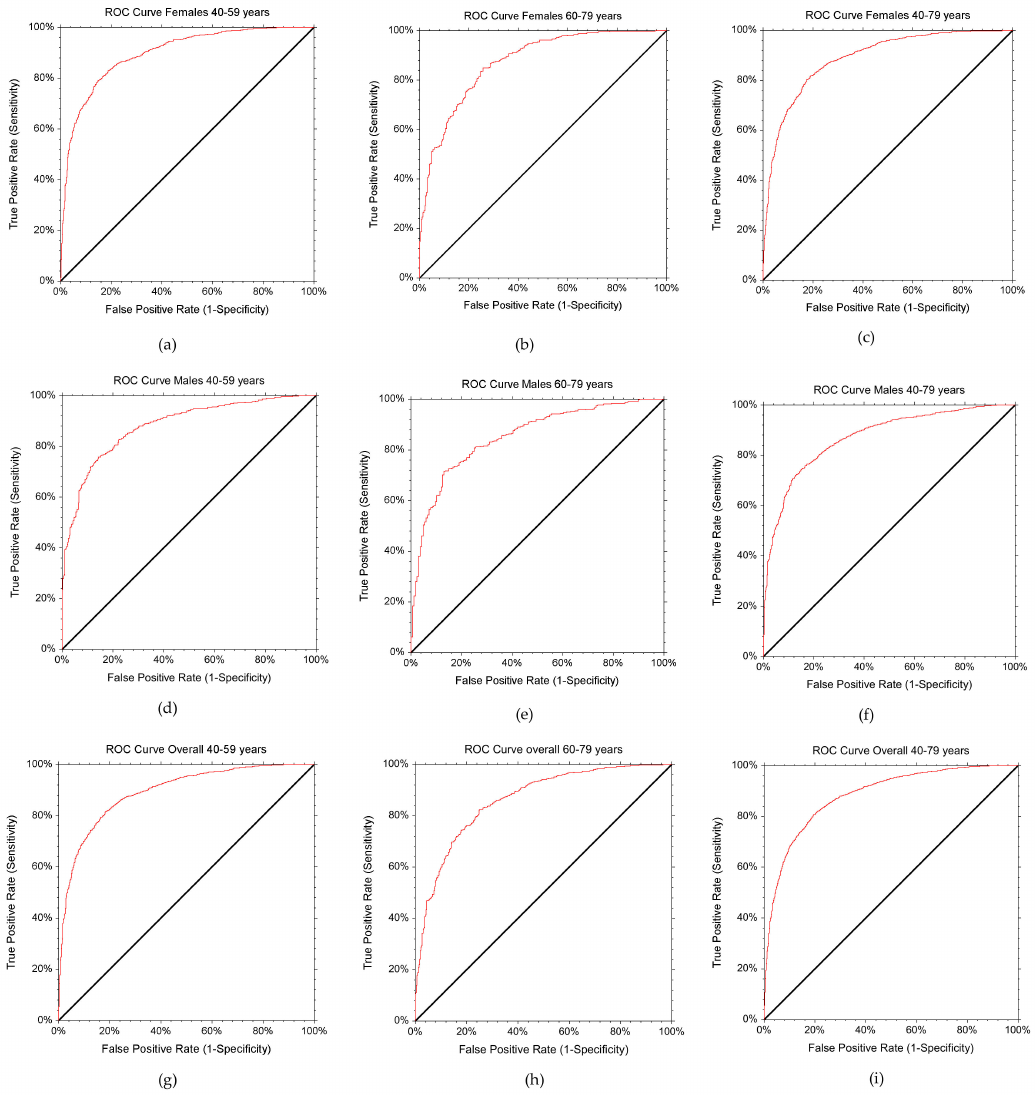
Figure 2. Receiver operator characteristic curve by age and gender for BMI cut-off point to